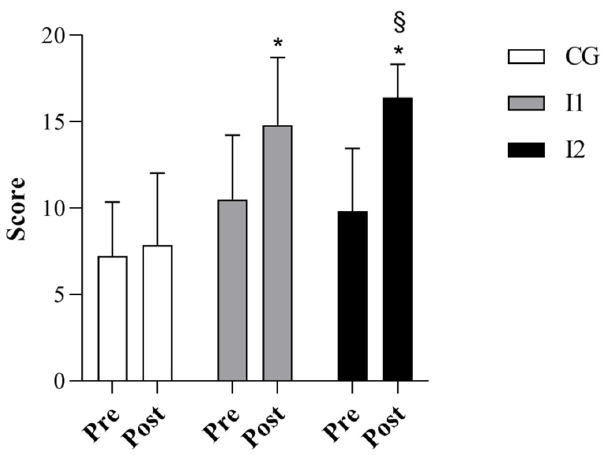
Figure 2. The score of locomotor skills in CG, I1 and I2 groups. * p < 0.001 I1 and I2 vs. CG; § p < 0.05 I2 vs. I1.